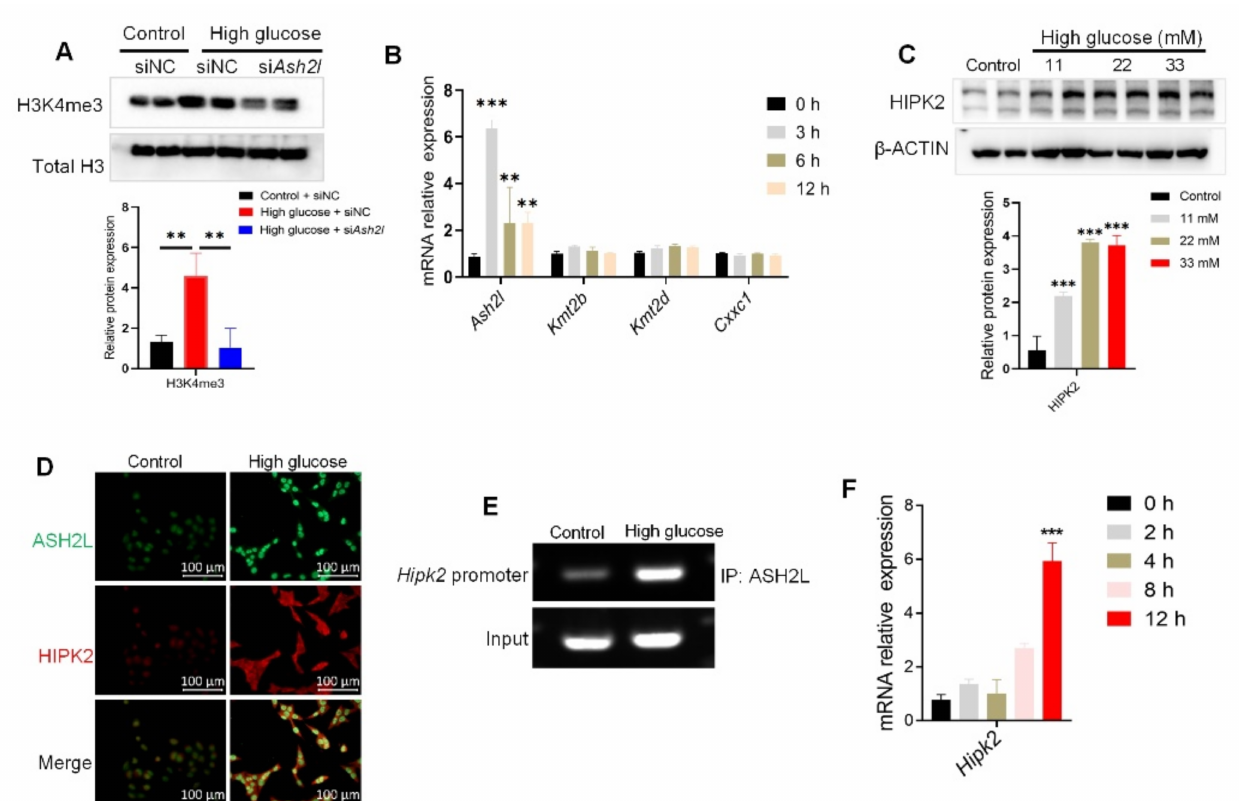
Figure 3. ASH2L-mediated H3K4me3 promotes HIPK2 transcription in high glucose-induced mesan- gial cells. ( A ) Western blot analysis of H3K4me3 in SV40-MES-13 cells treated with or without 33 mM high glucose for 24 h after being transfected with negative control (siNC) or ASH2L small interfering RNA (si Ash2l ). Data from at least three independent experiments are shown as mean ± S.D and ** p < 0.01. ( B ) Quantitative RT-PCR analyses of Ash2l , Kmt2b , Kmt2d, and Cxxc1 in SV40-MES-13 cells treated with 33 mM D-glucose for 0, 3, 6, and 12 h. Data from at least three independent experiments are shown as mean ± S.D, ** p < 0.01, and *** p < 0.001 compared with the control group. ( C ) Western blot analysis of HIPK2 expression in SV40-MES-13 cells treated with 11 mM, 22 mM, and 33 mM high glucose for 24 h. Data from at least three independent experiments are shown as mean ± S.D and *** p < 0.001 compared with the control group. ( D ) Immunofluorescence staining of ASH2L and HIPK2 in SV40-MES-13 cells treated with or without 33 mM D-glucose for 24 h. ( E ) ChIP-PCR assay of the 0–500 bp promoter region of HIPK2 in SV40-MES-13 cells treated with 33 mM high glucose for 24 h. ( F ) Quantitative RT-PCR analyses of Hipk2 in SV40-MES-13 cells treated with 33 mM high glucose for 0, 2, 4, 8, and 12 h. Data are shown as mean ± S.D and *** p < 0.001 compared with the control